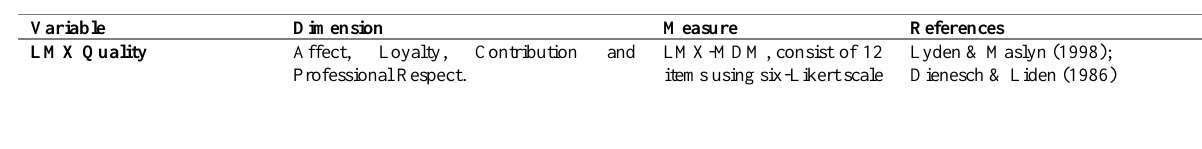
Table 1: Measure of Variables